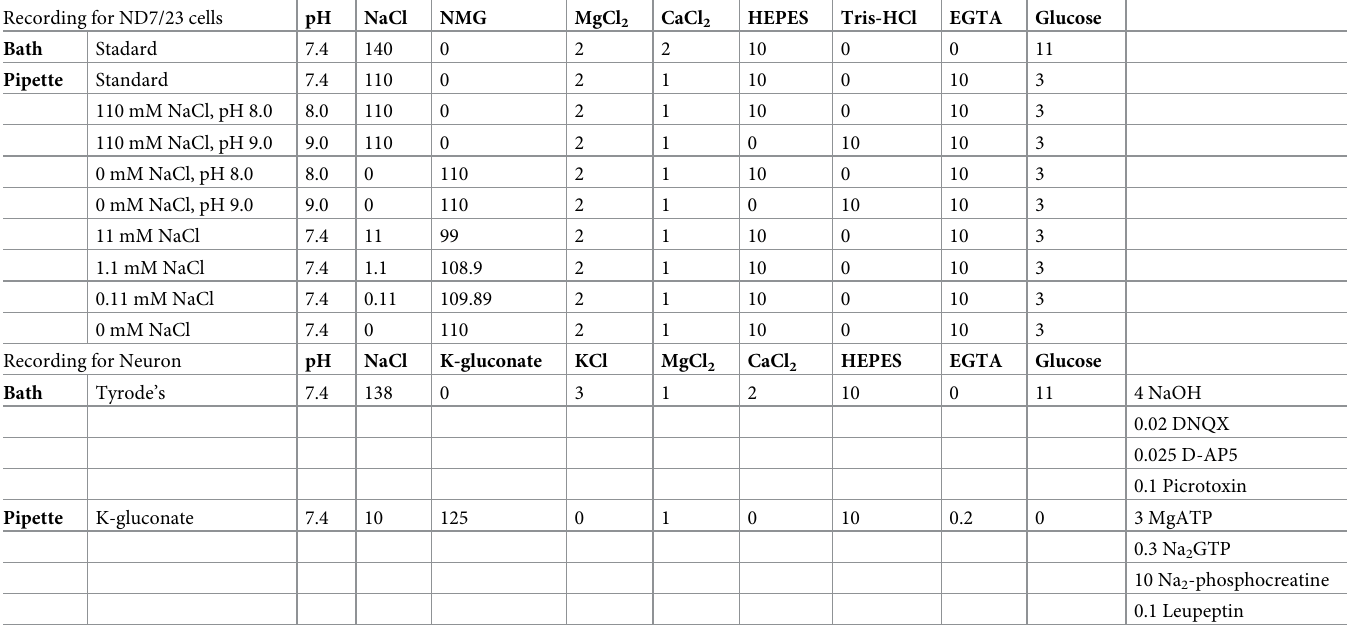
Table 1. Composition of bath and pipette solutions in experiments with ND7/23 cells and neurons. Recording for ND7/23